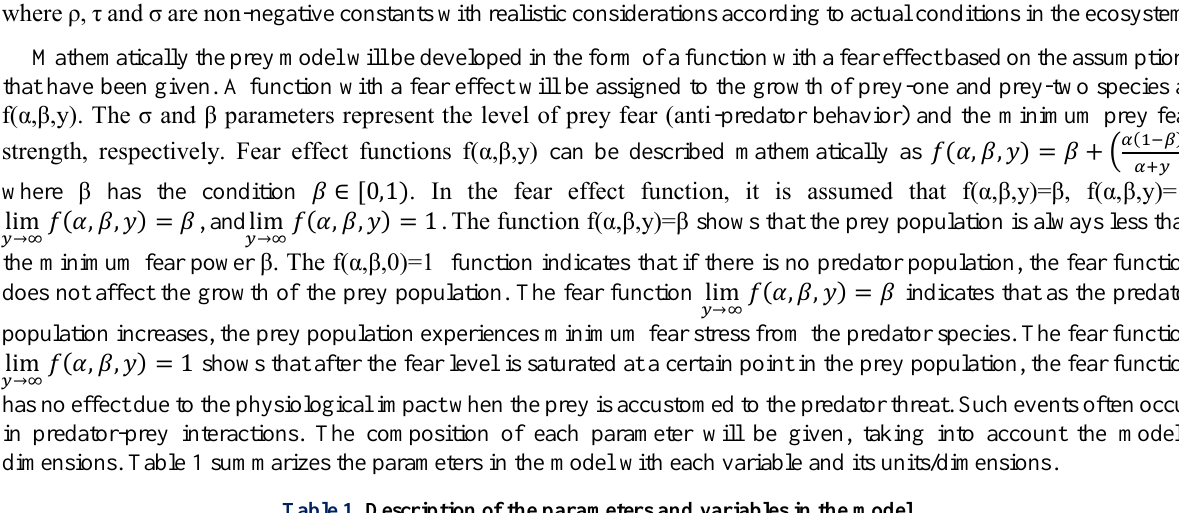
Table 1. Description of the parameters and variables in the